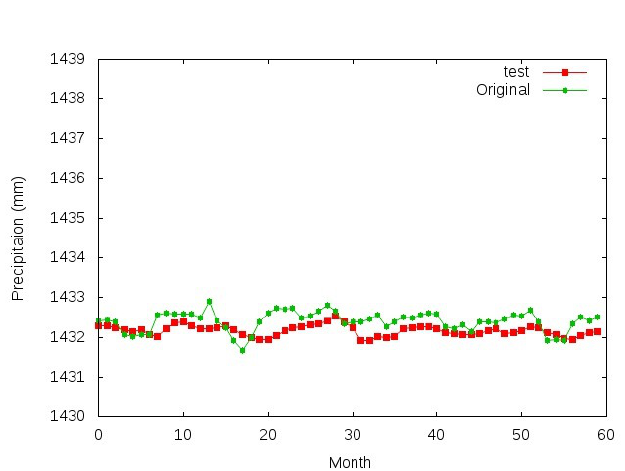
Fig. 10: Result under 200 hidden units and x function